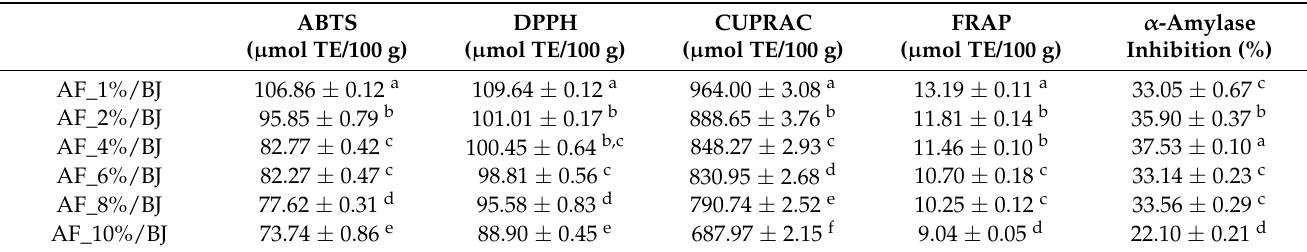
Table 4. Antioxidant activity of apple fiber/blackberry juice complexes and inhibition of α -amylase